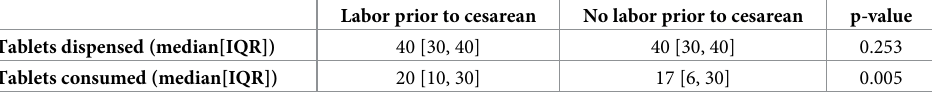
Table 2. Summary of opioid tablets dispensed, consumed, and leftover for women who labored or did not labor prior to cesarean